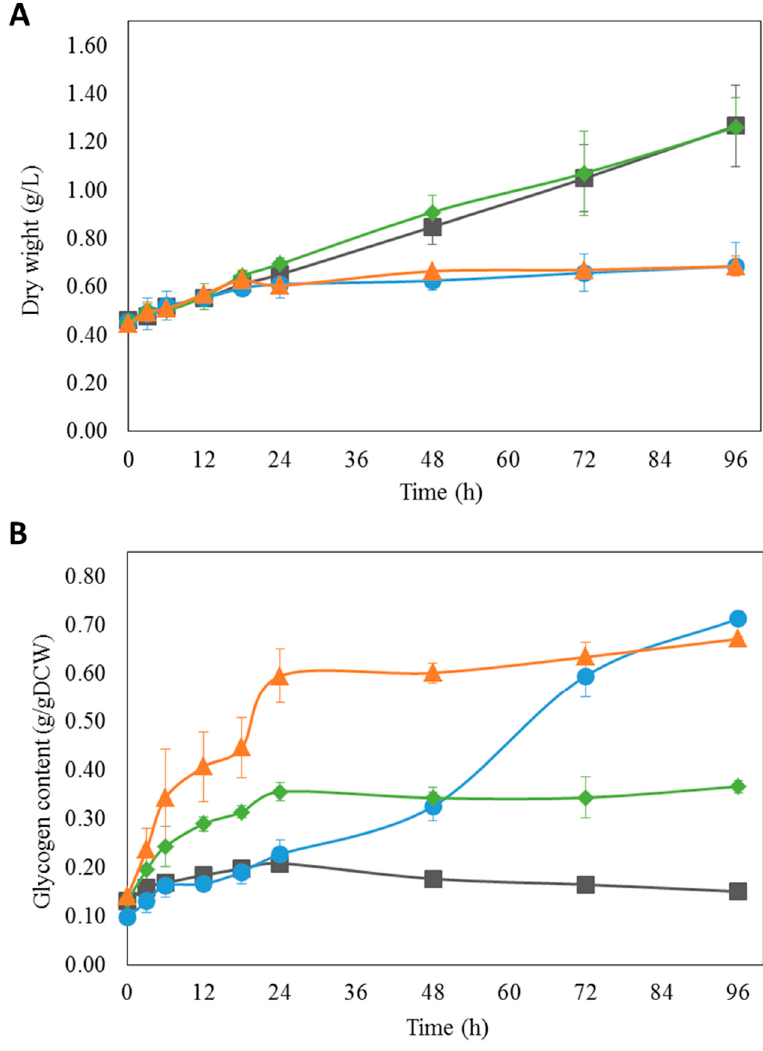
Figure 5. Growth ( A ) and glycogen content ( B ) of A. platensis C1 under nutrient starvation at 0–96 h. Culture conditions of Control ( ), NO 3 − - ( ), PO 43 − - ( ) and SO 42 − - limited ( ).